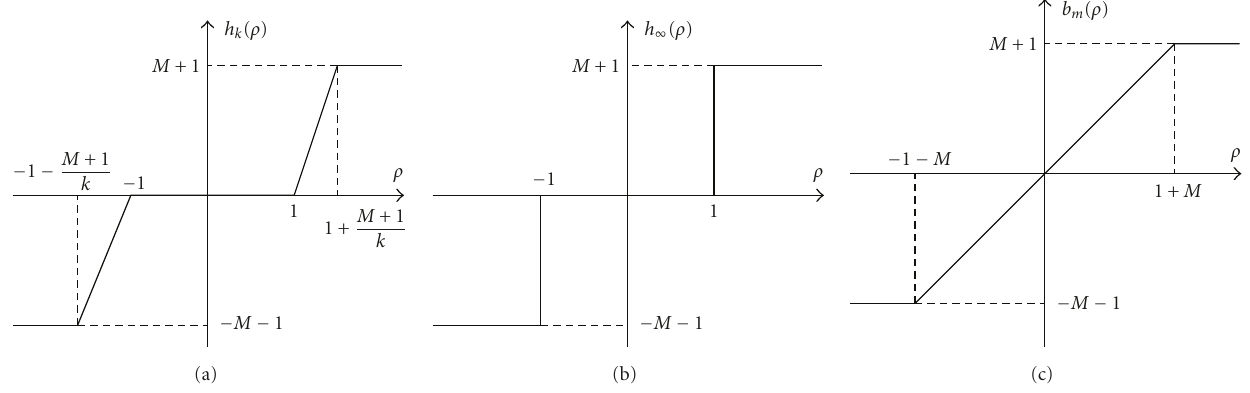
Figure 5: Auxiliary maps (a) h m , (b) h ∞ , and (c) b m employed in the proof of Property 3.